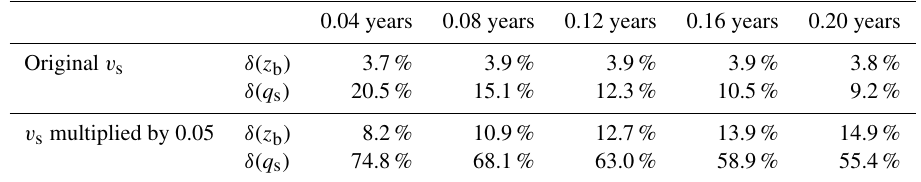
Table 2. Quantification of the difference between predictions of the flux form and the entrainment form in the case of uniform sediment. The maximum values of δ ( z b ) and δ ( q s ) in the calculational domain are presented every 0.04 years.